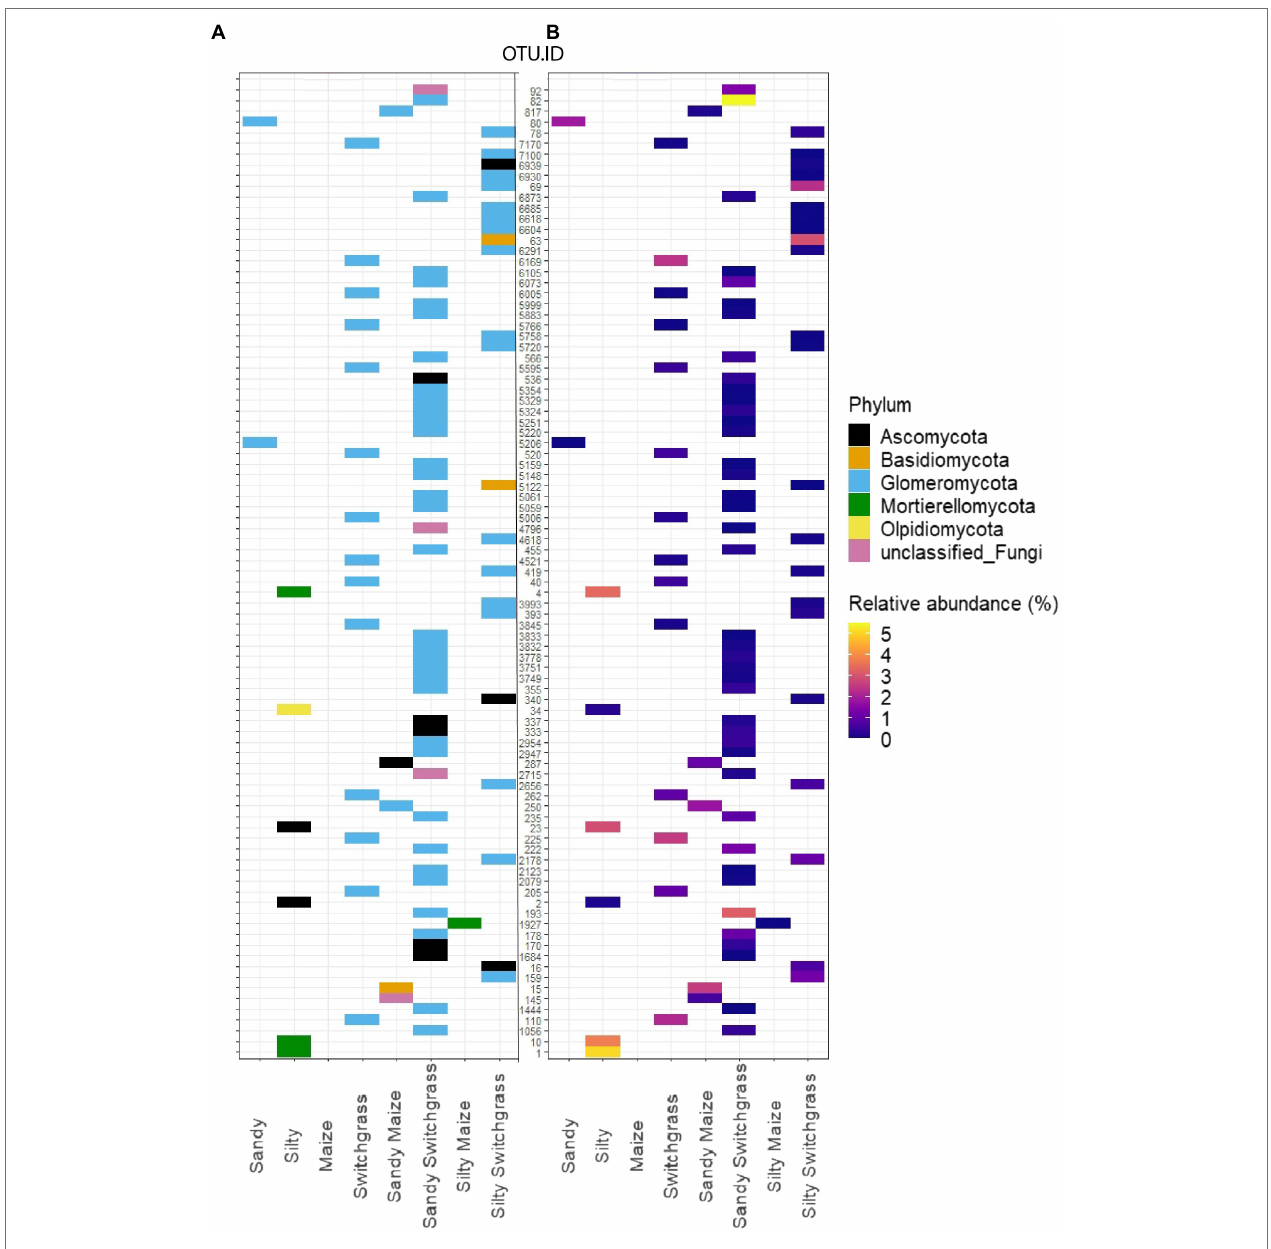
FIGURE 3 | Schematic representation of all RNA fungal indicator species within each site, crop, and site/crop combination which can be found within Supplementary File 2 . Indicator species represented as a heatmap matrix colored by phylum (A) and average relative abundance (%; B ). OTU were selected by significance ( α < 0.05) and indicator value (IV > 0.7) for a specific crop or